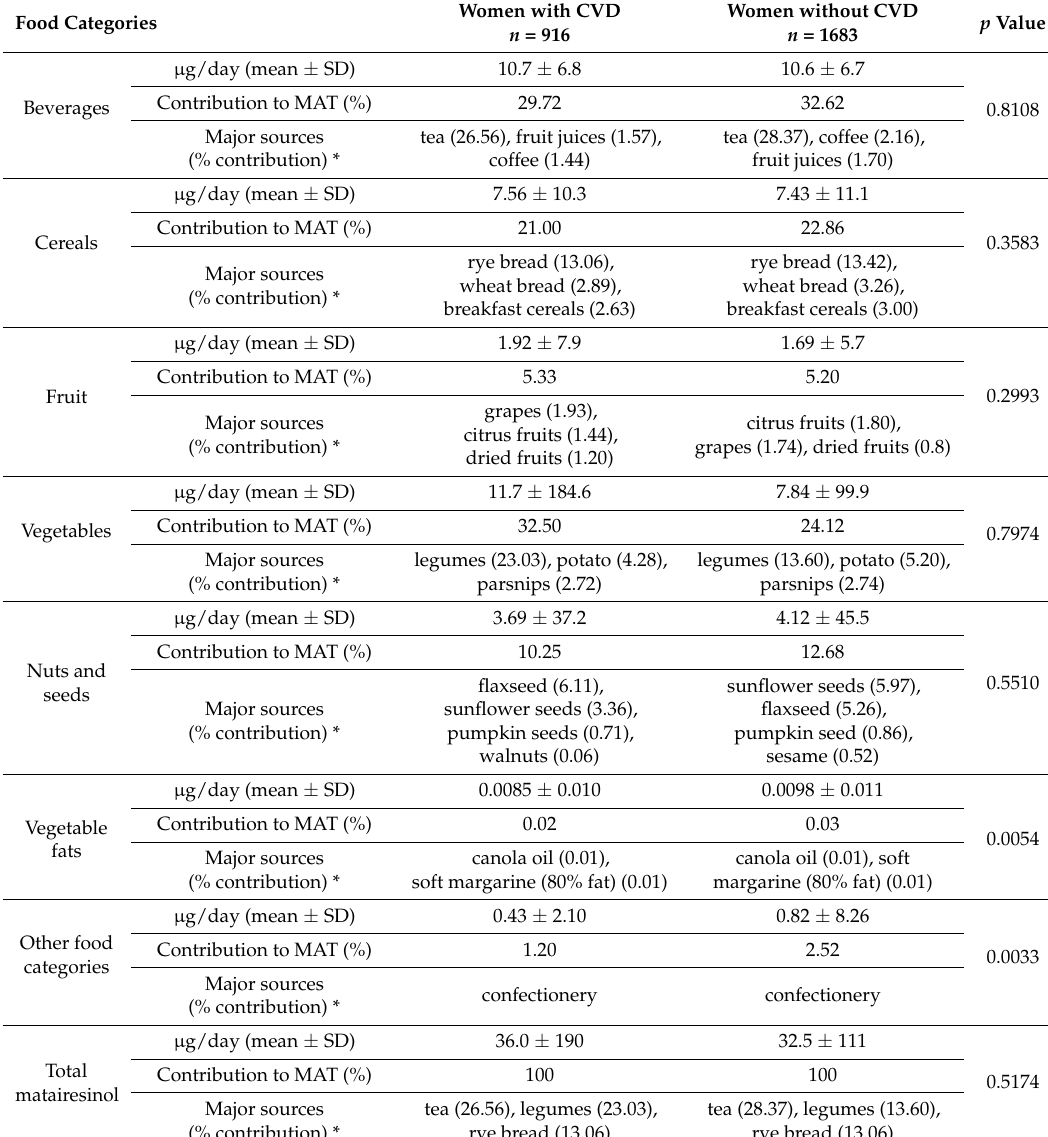
Table 6. Contributions of food categories and individual food products to matairesinol (MAT) intake in women with and without